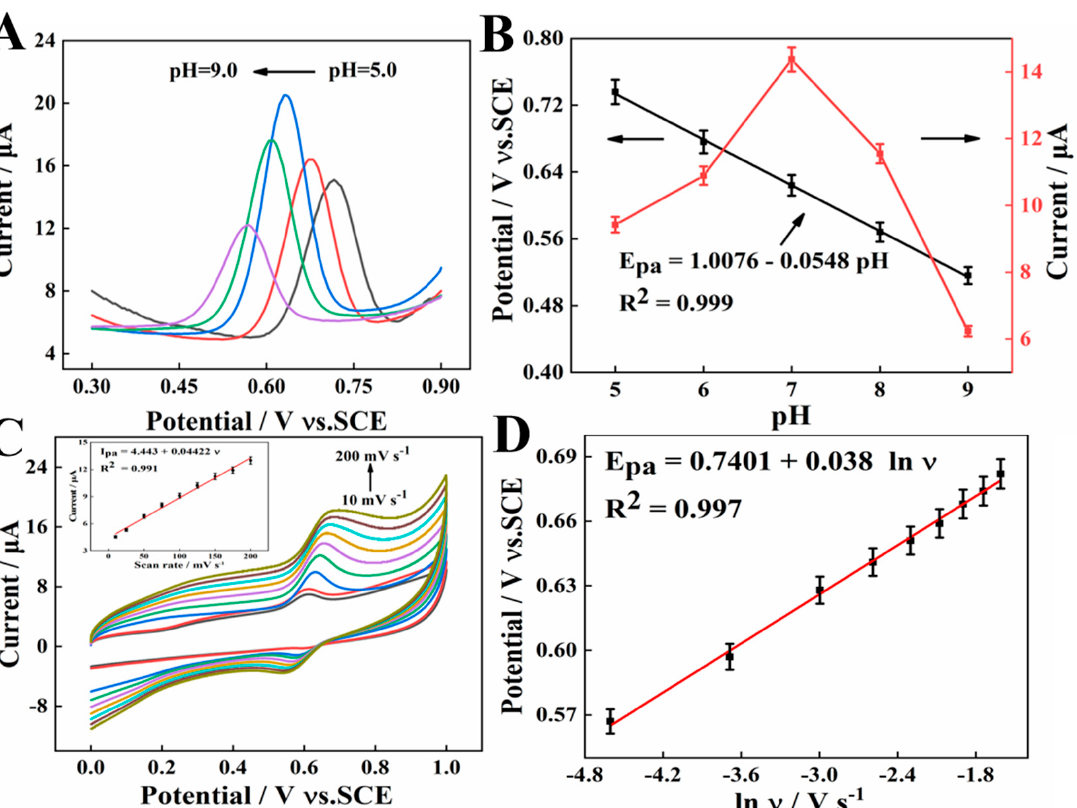
Figure 6. ( A ) SWV curves of 10 µ M SY at AGCE in PBS with different pH. ( B ) The plots of pH vs. E pa . ( C ) CVs at the pH 7.0 PBS with different scan rates (from 10 to 200 mV s − 1 ) (Inset The relationship of I pa and ν .) ( D ) The linear relationship between the peak potential and ln ν .